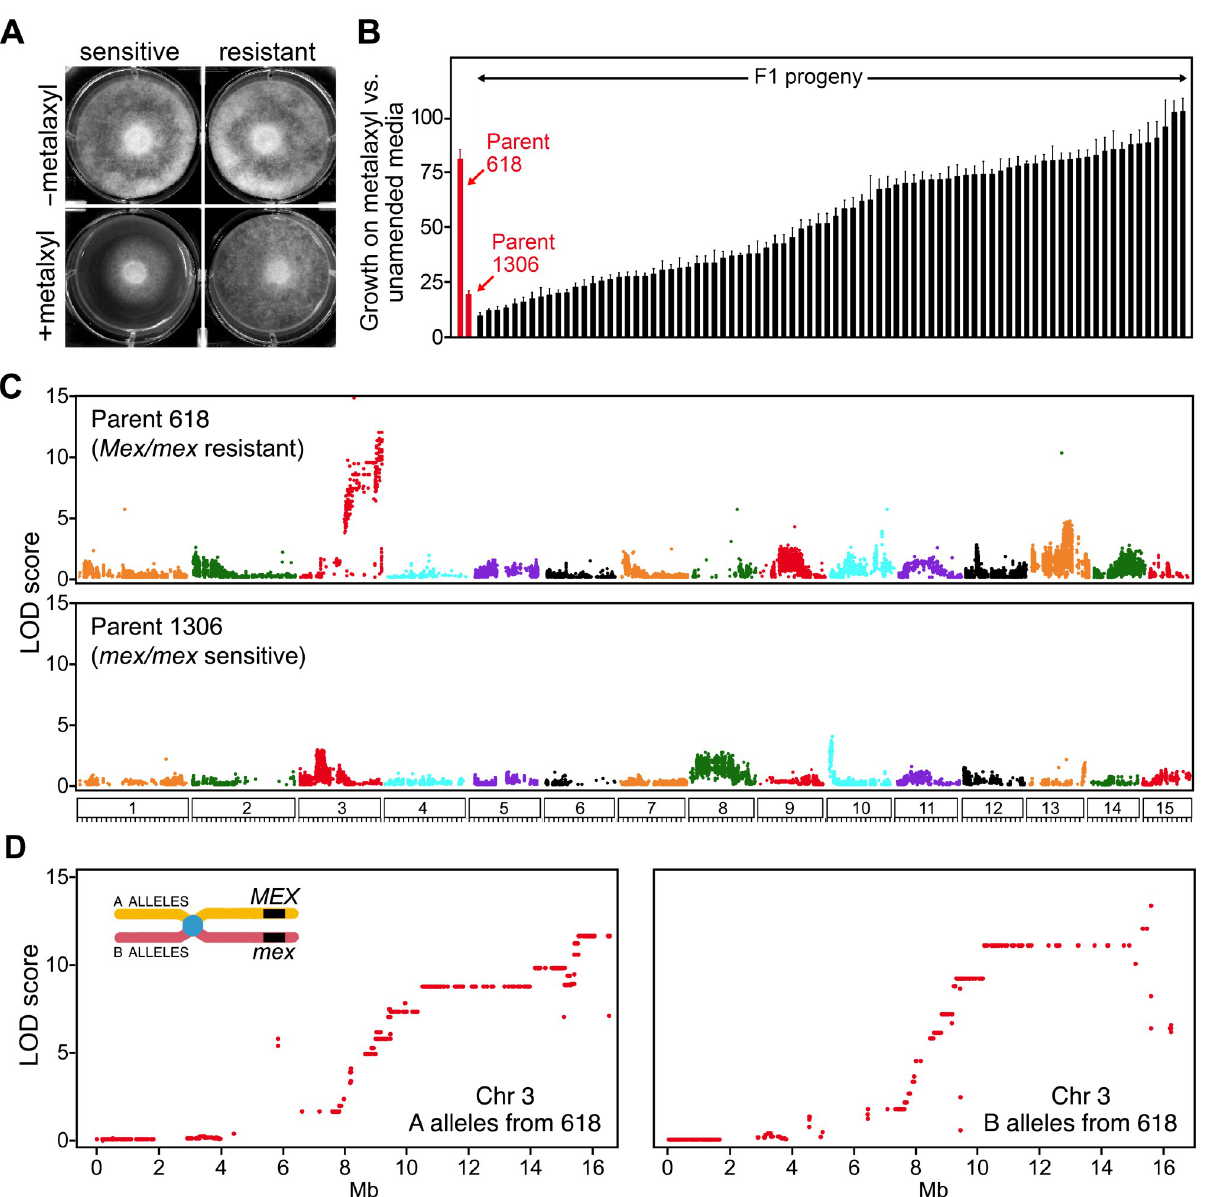
Fig 9. Mapping loci determining insensitivity to metalaxyl. A , growth of representative sensitive and resistant strains on unamended media (-) or media containing 0.5 μ g/ml of metalaxyl (+). B , sensitivity of parents and their F1 progeny. Parents 618 and 1306 are inferred to be Mex/mex and mex/ mex , respectively. C , genome-wide linkage analysis of SNP markers from 618 and 1306. D , detail of linkage of markers from the alternate haplotypes of Chr3 from parent 618. The chromosome illustration shows that A and B alleles are in cis and trans to the haplotype bearing the resistant Mex